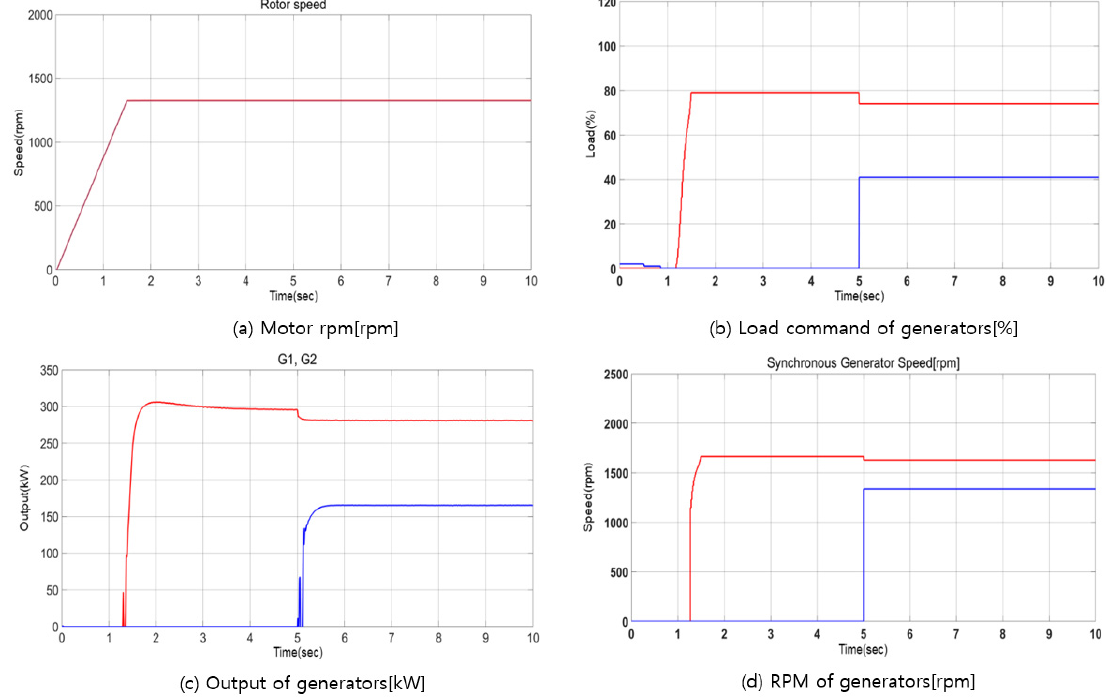
Figure 22. Simulation results of propulsion motor and generators when load varies as 40 → 40%.